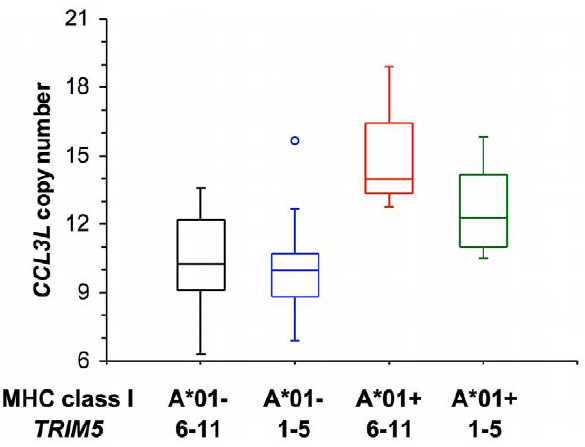
Figure 3. Distribution of CCL3L copy number in a cohort of Indian-rhesus monkeys. Rhesus monkeys are divided into 4 groups according to their expression of Mamu-A*01 allele (A*01 2 and A*01 + ) and selected TRIM5 alleles ( TRIM5 1–5: one expressing only TRIM5 alleles 1–5, TRIM5 6–11: the other expressing only TRIM5 alleles 6–11).